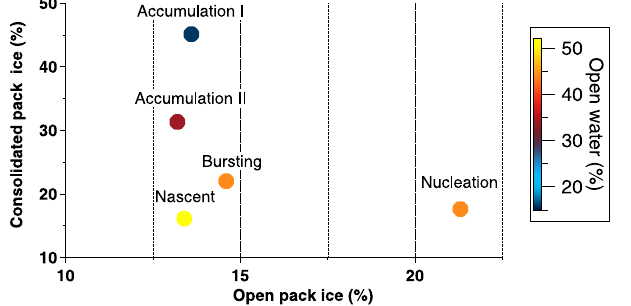
Figure 2. Percentages of total time (hours) of air mass back trajectories travelling over different sea ice areas for each of the 5 aerosol